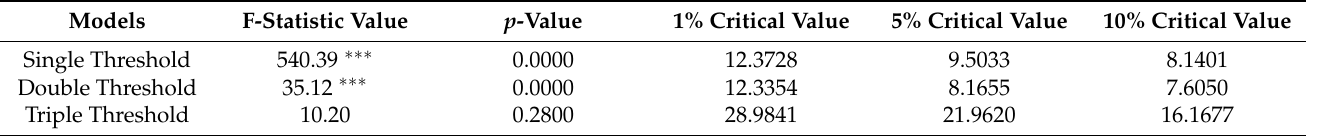
Table 6. Results of the threshold effect test.